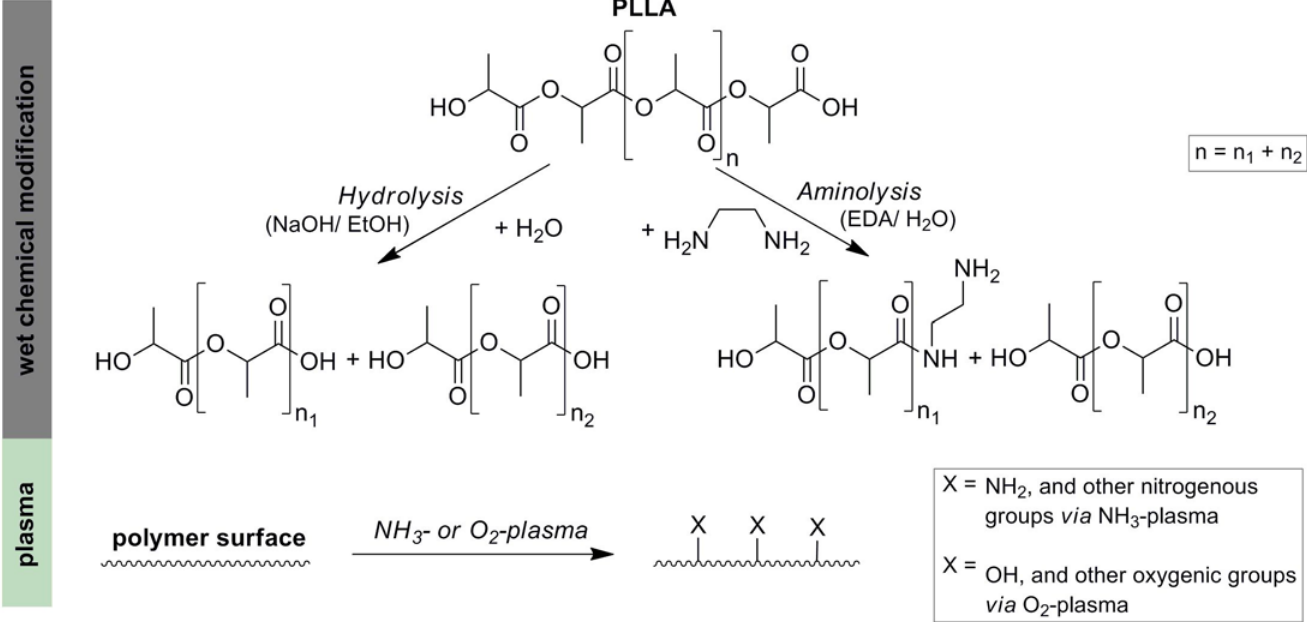
Fig 1. Chemical reactions of the performed wet- and plasma-chemical modifications. Supposed schematic modifications are exemplary demonstrated for PLLA. Wet-chemical polymer surface modifications were performed by alkali hydrolysis (NaOH in ethanol) generating OH groups or by aminolysis (EDA in water) generating NH 2 groups. Plasma chemical methods were used to generate NH 2 and other nitrogenous groups (NH 3 -plasma) or OH and other oxygenic groups (O 2